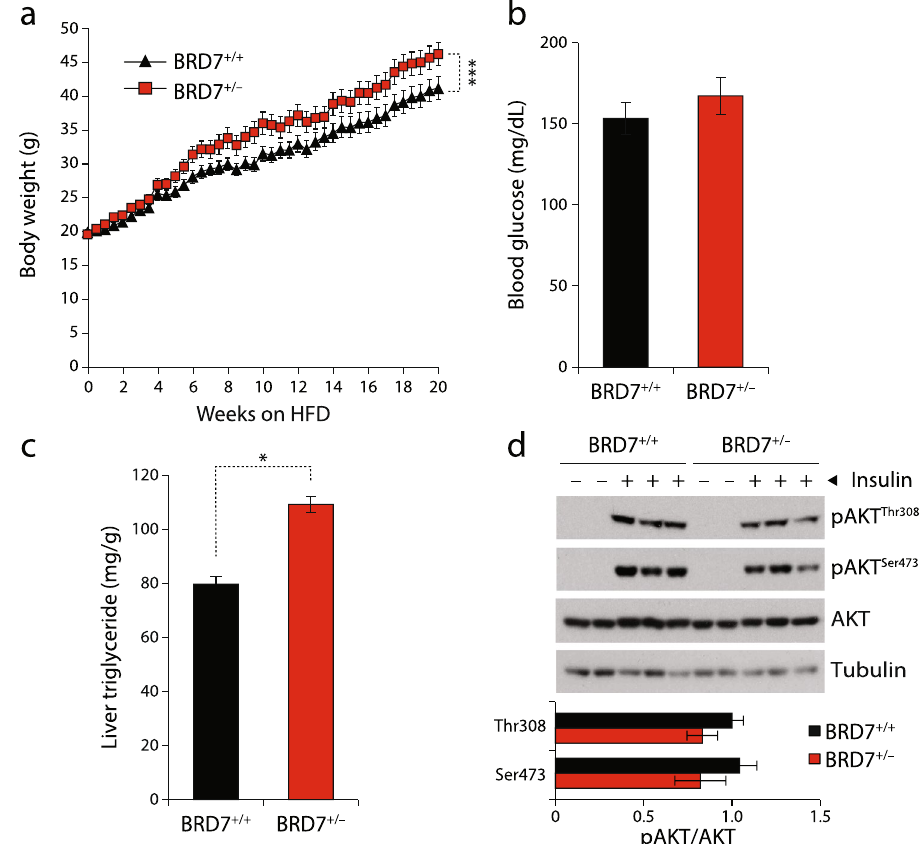
Figure 3. BRD7 + / − mice fed a HFD display increased body weights. ( a ) Body weights of male BRD7 + / + and BRD7 + / − mice over 20 weeks on a HFD (n = 10/each group). ( b ) Blood glucose levels after 6 hours of fasting on week 10 of HFD feeding. ( c ) Liver triglyceride contents. Mice were fasted for 6 hours. ( d ) Immunoblots of pAKT Thr308 and pAKT Ser473 in the liver of BRD7 + / + and BRD7 + / − mice after infusion of saline or insulin (1.5 IU/kg) after 22 weeks of HFD (top). Quantification of the blots showing normalized ratio between pAKT and AKT in insulin-infused livers (bottom). Error bars are represented as mean ± SEM., P values were determined by Student’s t -test. ( * p < 0.05, ** p < 0.01, *** p < 0.001). Significance was determined by two-way analysis of variance (ANOVA) with Bonferroni multiple-comparison